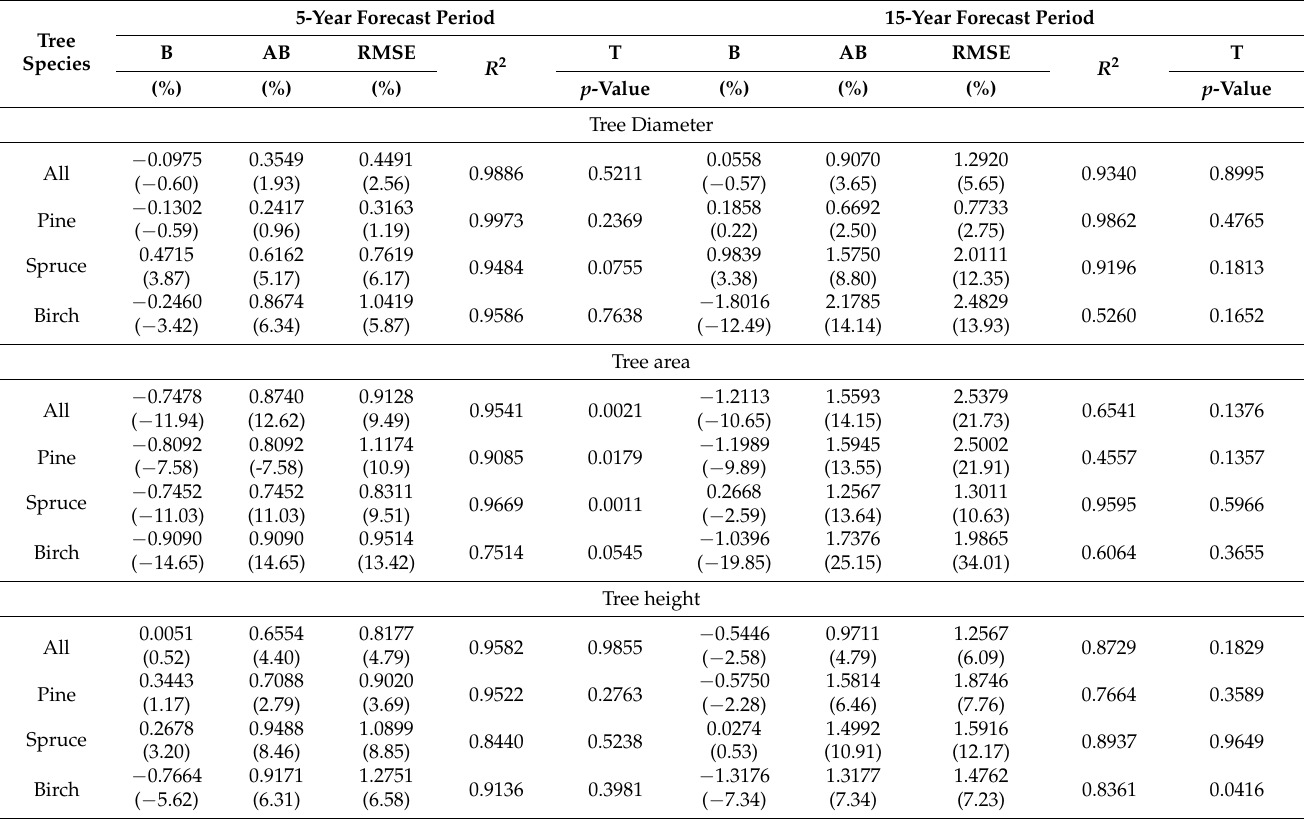
Table 6. Statistical measures and p -values of the Student’s t -test for the forecasts of the whole-stand scenario